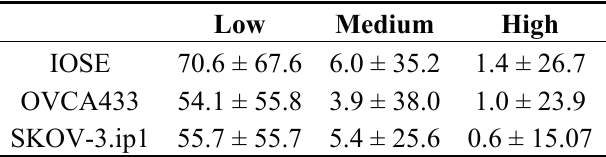
Figure 8. Representative cytoskeleton images (left = phalloidin; middle = anti-vinculin) for SKOV-3.ip1 cells on the LN high slope gradient for ( a ) low concentration; ( b ) medium concentration; and ( c ) high concentration regions. Scale bar = 40 microns. The right column is the f-actin angular distribution relative to the fiber axis, showing an increase in stress fiber alignment at higher LN concentration. The focal adhesion localization on the LN similarly increased. The statistical analysis for stress fibers and focal adhesions is given in Tables 6 and 7, respectively. Table 6. F-actin mean angle and distribution relative to the long axis for the cells lines on the low slope gradient. The average angle for three concentration regions of each cell type was statistically different. n = 300 to 500 stress fibers per region and the errors are standard